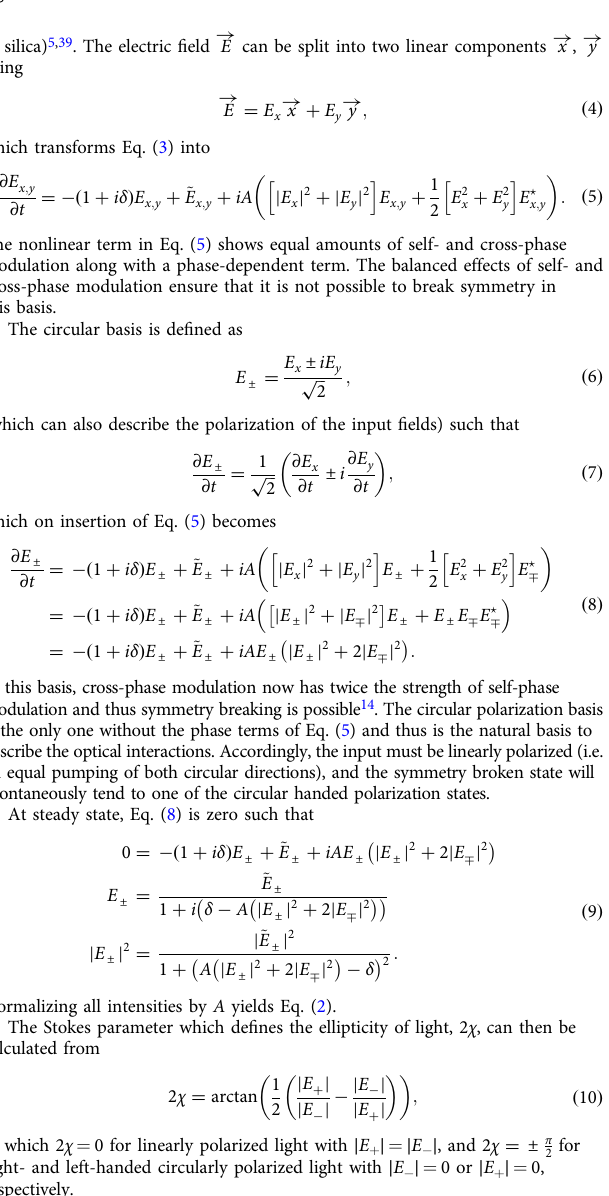
Fig. 5 Design of the layer stack of the Bragg mirror. The height of the bars indicates the refractive index n of the silica fi ber core (gray), coated SiO 2 (light blue) and coated Ta 2 O 5 (blue). The red line shows the electric fi eld intensity ∣ E ∣ 2 formed by the normalized incoming wave coming from the right side and the re fl ected